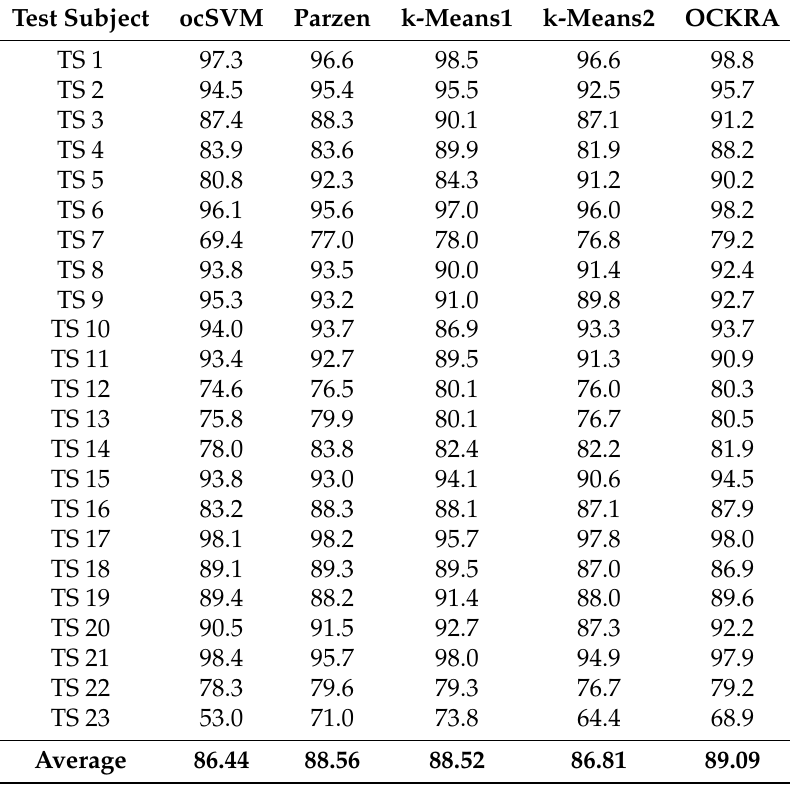
Table 5. Area (percentage) under the curve for TPR versus